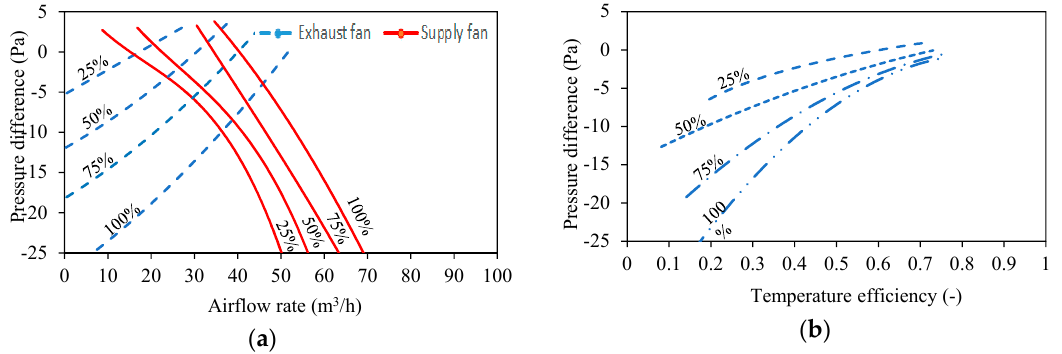
Figure 10. ( a ) Measurement based fan performance curves of room-based ventilation units with ceramic regenerative HEX; ( b ) measurement based temperature efficiencies of room-based ventilation units with ceramic regenerative HEX.